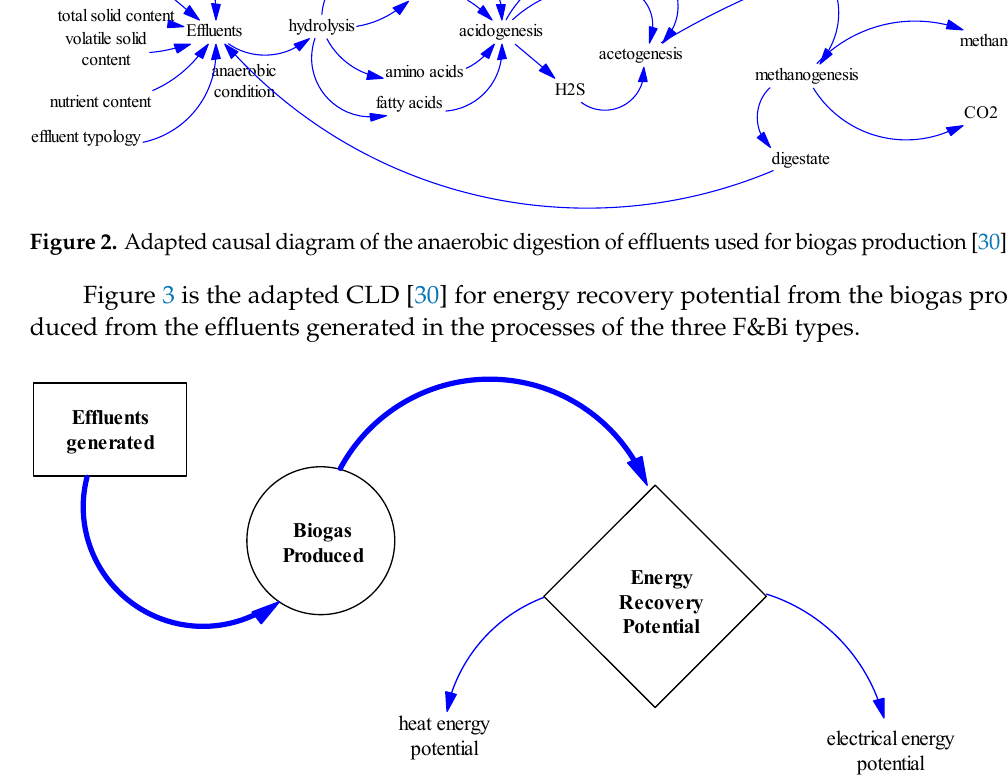
Figure 3. Causal diagram for effluents, biogas production, and energy recovery for CHP use.